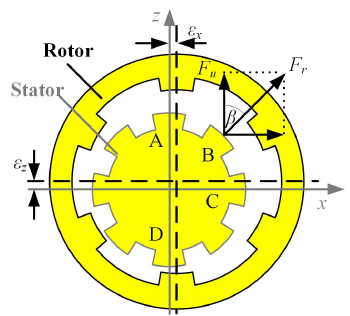
Figure 2. The vertical UEMF induced by